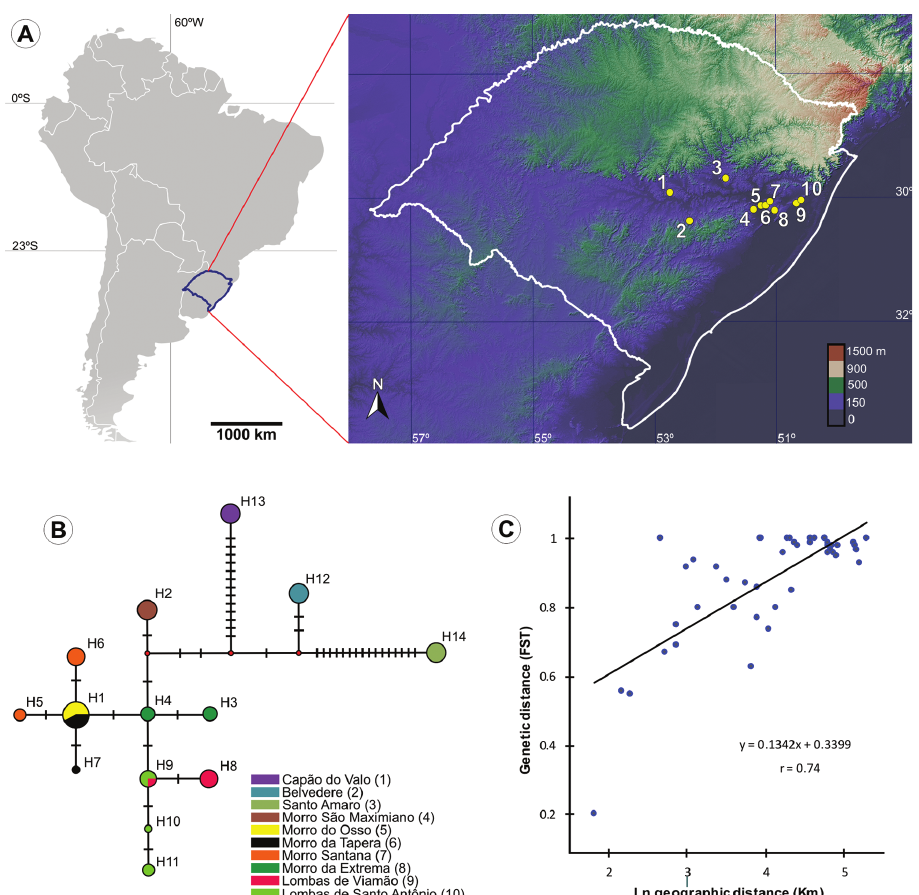
Figure 11. Geographic distribution and genetic variation among populations of C. pampeanus within Rio Grande do Sul State, Brazil; A localities of populations studied (see Suppl. material 3 for exact geographic coordinates and elevations) B evolutionary relationships of COI haplotypes across ten popu- lations. The circles represent haplotypes; the diameter is proportional to the frequency in 60 analyzed individuals. Small red circles indicate intermediate vectors. Transversal bars represent mutational steps. Numbers in parentheses correspond to localities in the map ( A ) C correlation between pairwise geo- graphic distance and estimates of gene flow ( φ ST)